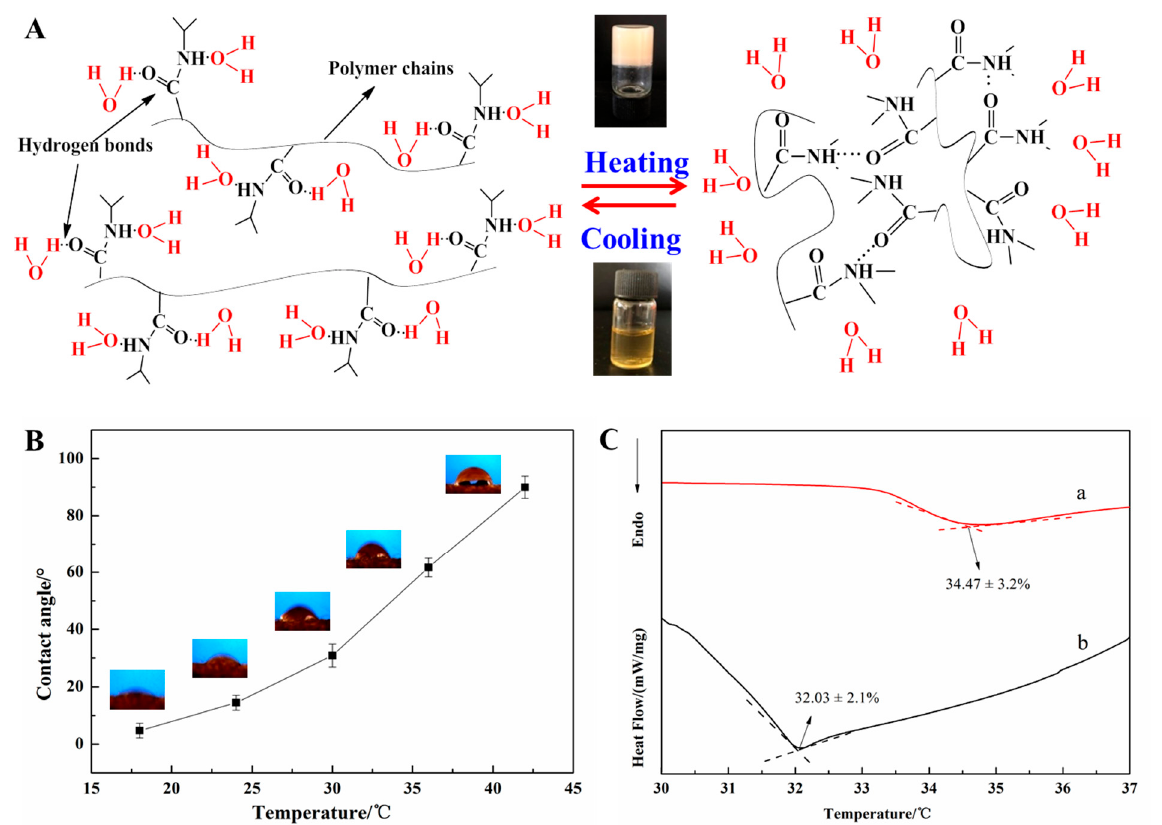
Figure 5. Representation of ( A ) the hydrophobic–hydrophilic phase transition of PNIPAM hydrogels; ( B ) Contact angle measurements of multifunctional cotton fabric at different temperatures; ( C ) Differential scanning calorimetry thermogram curves of modified cotton fabric and cotton fabric. ( a ) Cotton fabric; ( b ) Functionalized cotton fabric. (The final results of data are shown as mean ± standard deviation) .